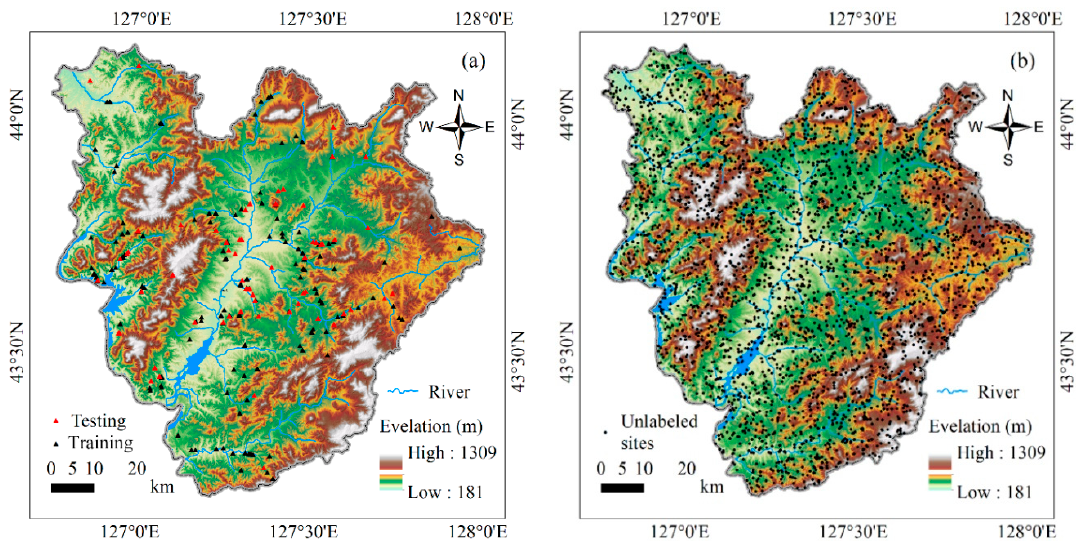
Figure 4. Labeled and unlabeled sites in study area. ( a ) Distribution of labeled data; ( b ) Distribution of unlabeled data.